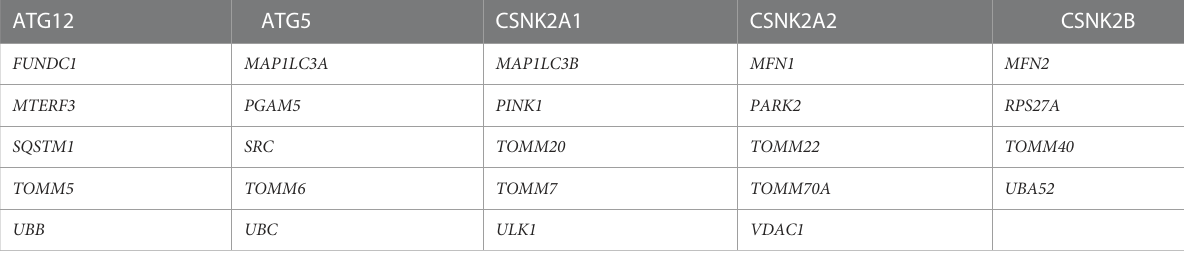
TABLE 2 29 mitophagy-related genes extracted from Reactome Pathway Database. ATG12